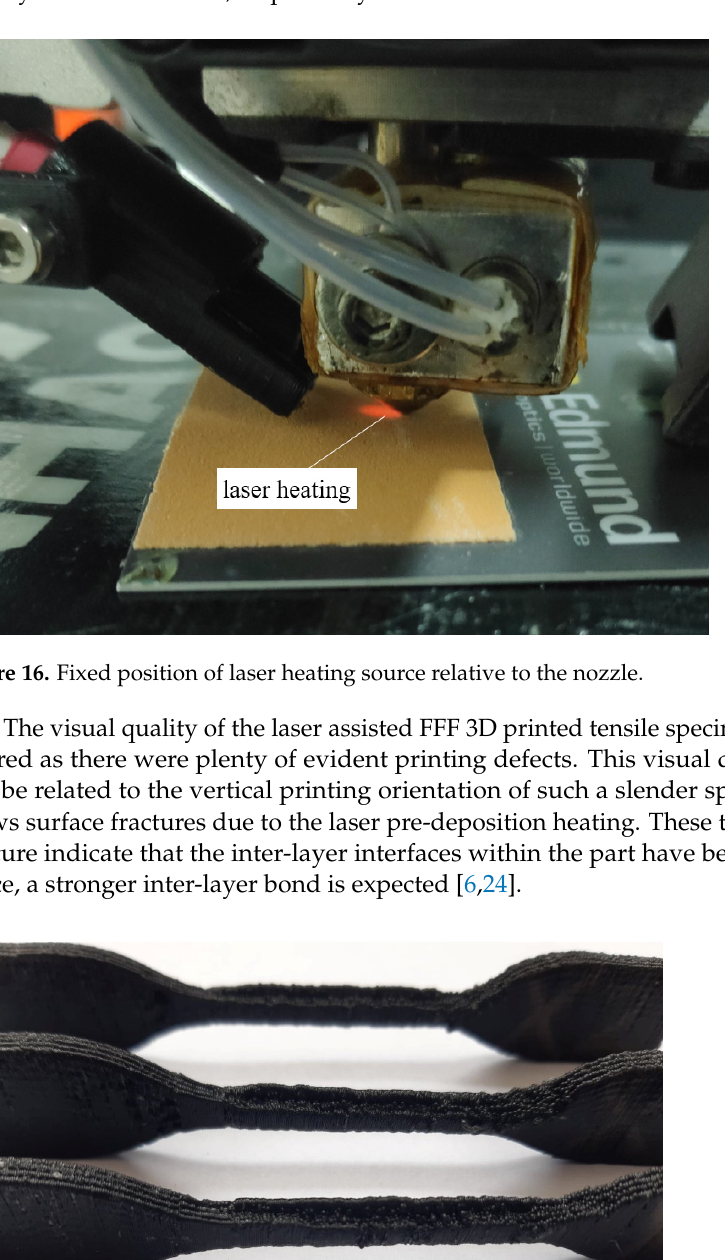
Figure 17. Laser assisted FFF printed tensile specimen.